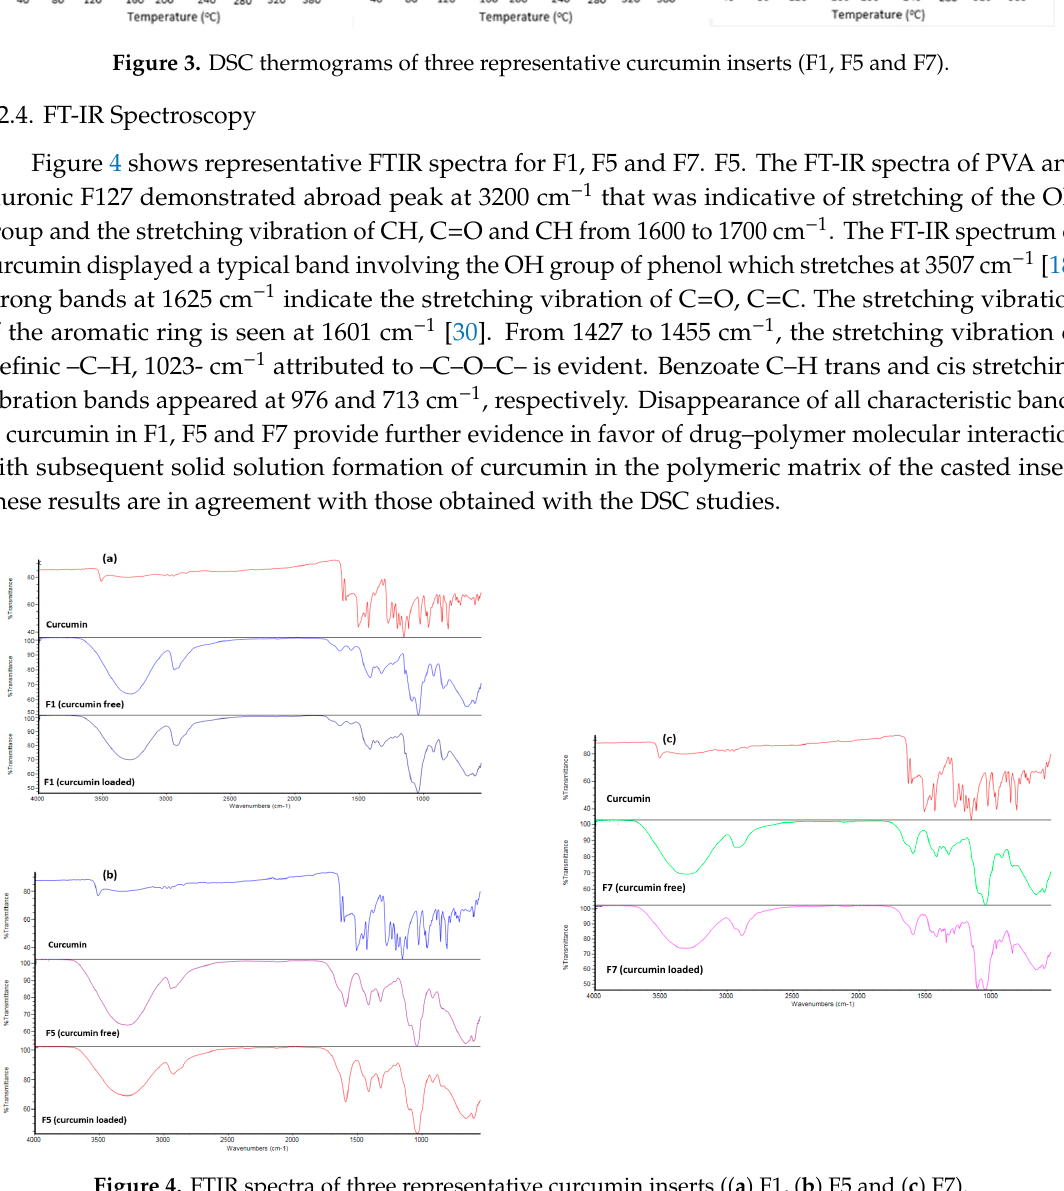
Figure 4. FTIR spectra of three representative curcumin inserts (( a ) F1, ( b ) F5 and ( c )